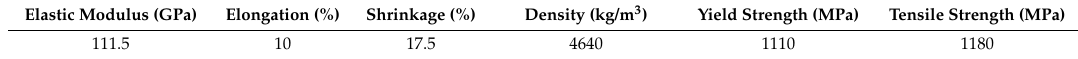
Table 2. Material physical